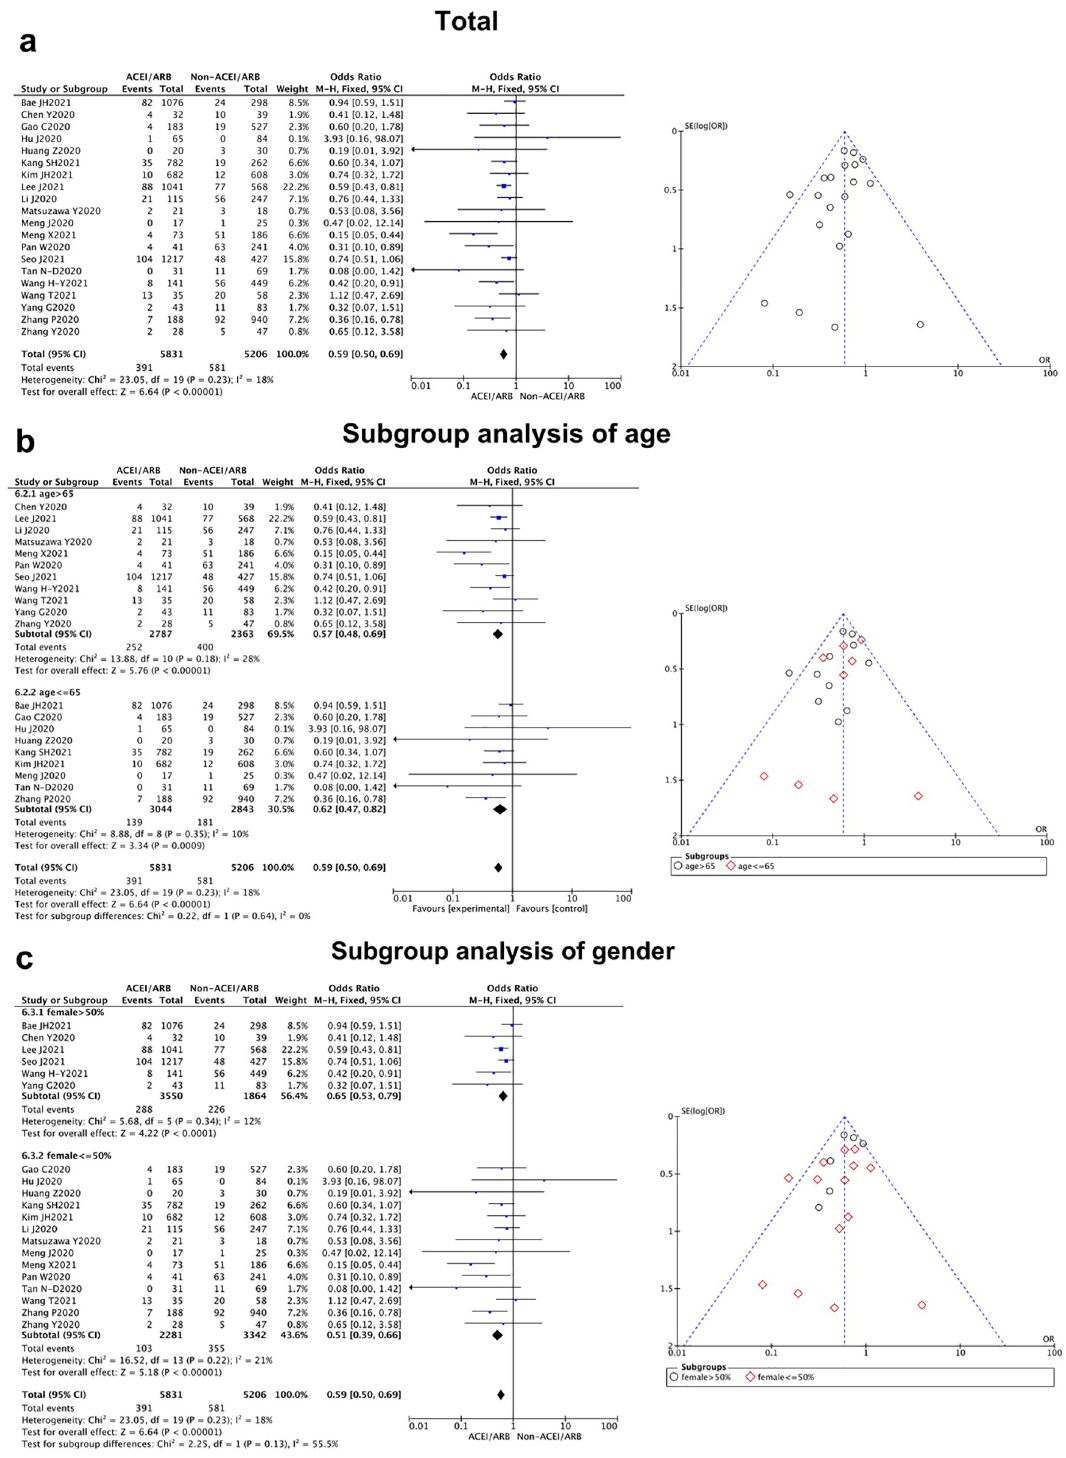
Fig 5. Mortality of East-Asian Covid-19 patients treated with ACEI/ARB vs. untreated subjects (HT subgroup). All-cause mortality data of OR and 95% CI from 20 studies were pooled in this meta-analysis and the result of meta-analysis was described as a forest plot. (a) The whole group analysis; (b) The subgroup analysis of age; (c) The subgroup analysis of gender.